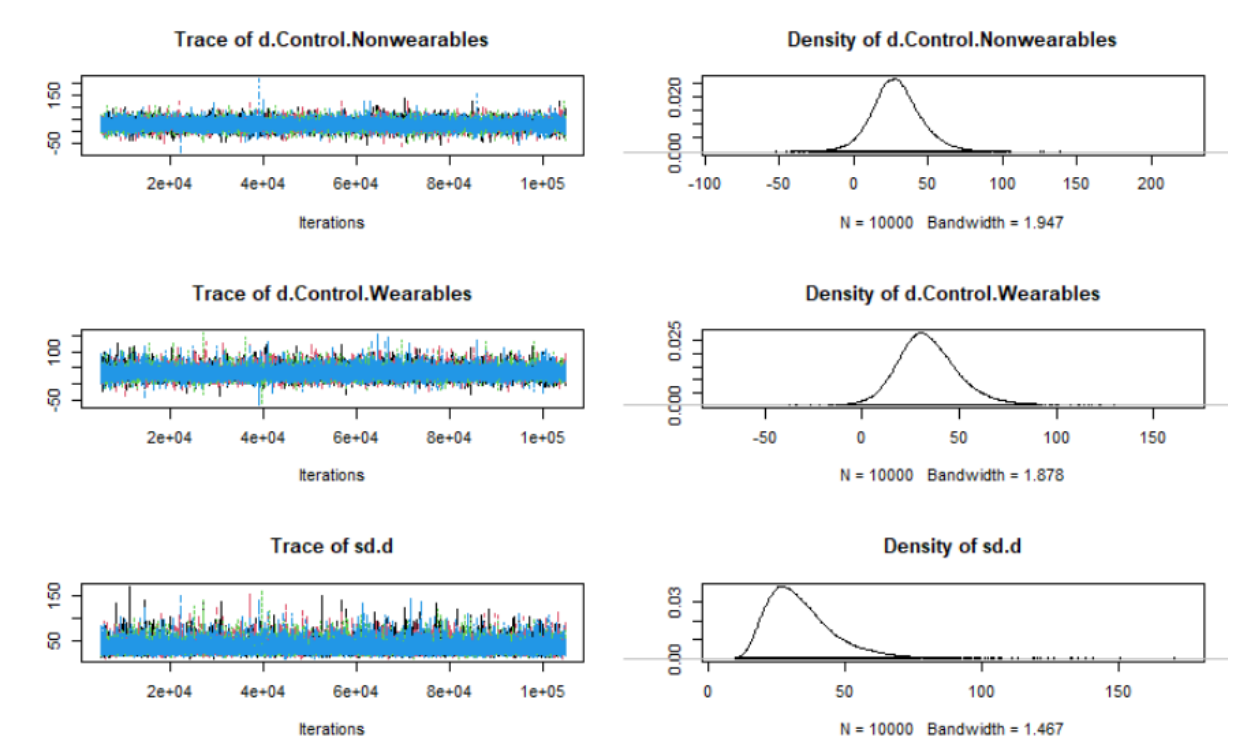
Figure 2. Markov Chain Monte Carlo simulation showing the trace plots and corresponding density plots. Convergence was achieved with higher iterations (100,000) and was suitable for the network model. SD—Standard deviation.